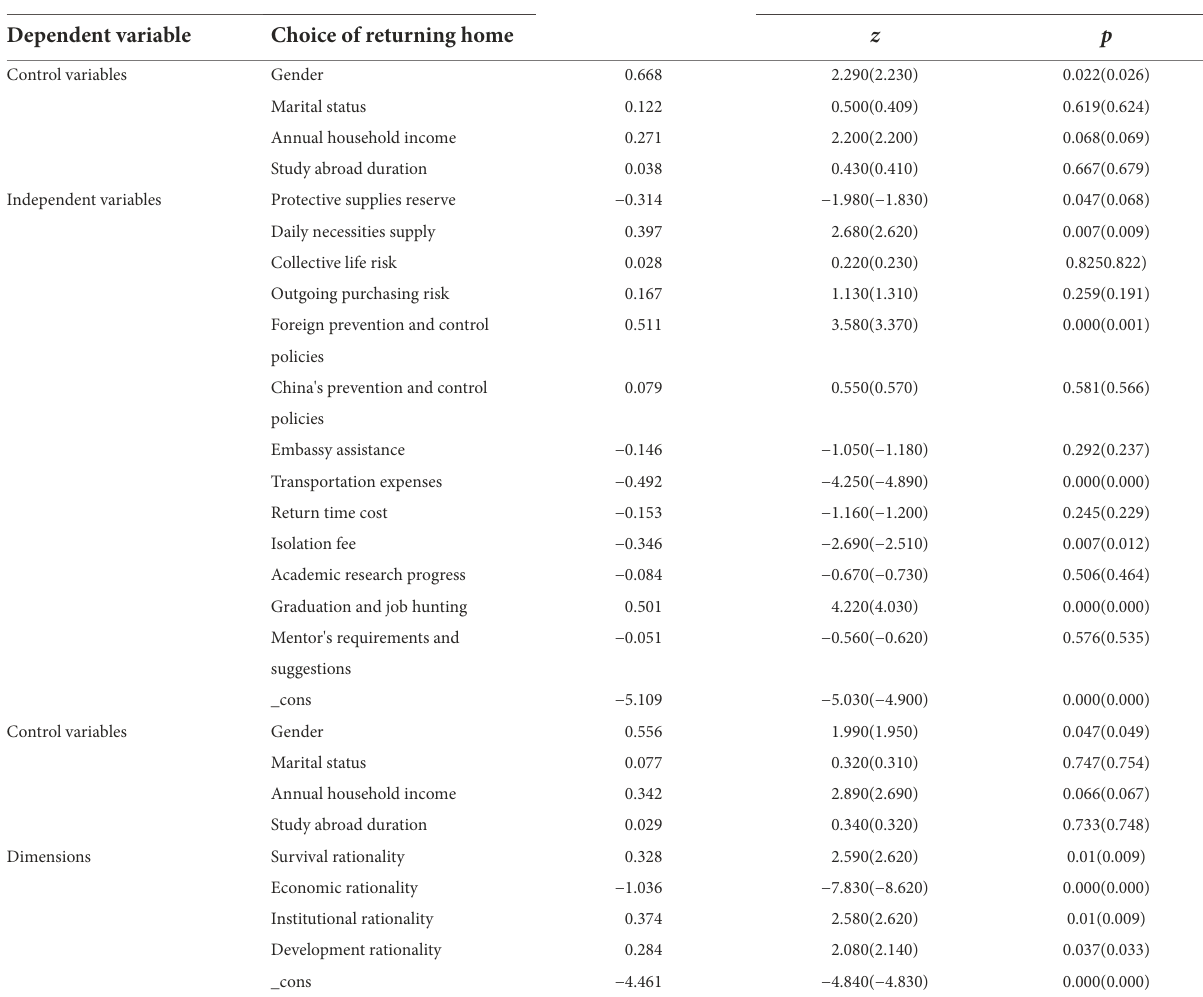
TABLE 8 Robustness test of related